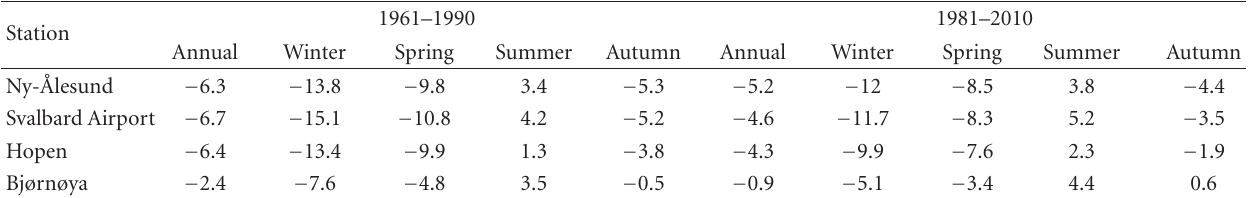
Table 1: Average annual and seasonal temperatures ( ◦ C) during 1961–90 and